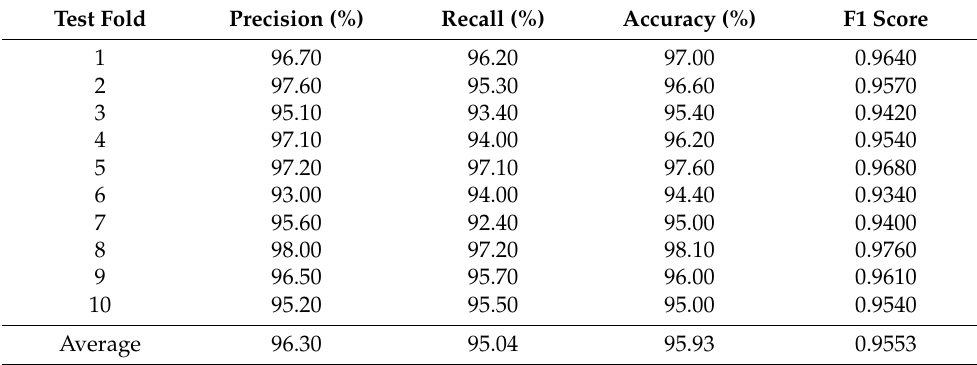
Table 12. Experimental results of K-fold cross-validation ( K f = 10) for Model #1–3 with 16 Kernel convolutional windows and 16 maximum pooling windows in each convolutional-pooling layer.